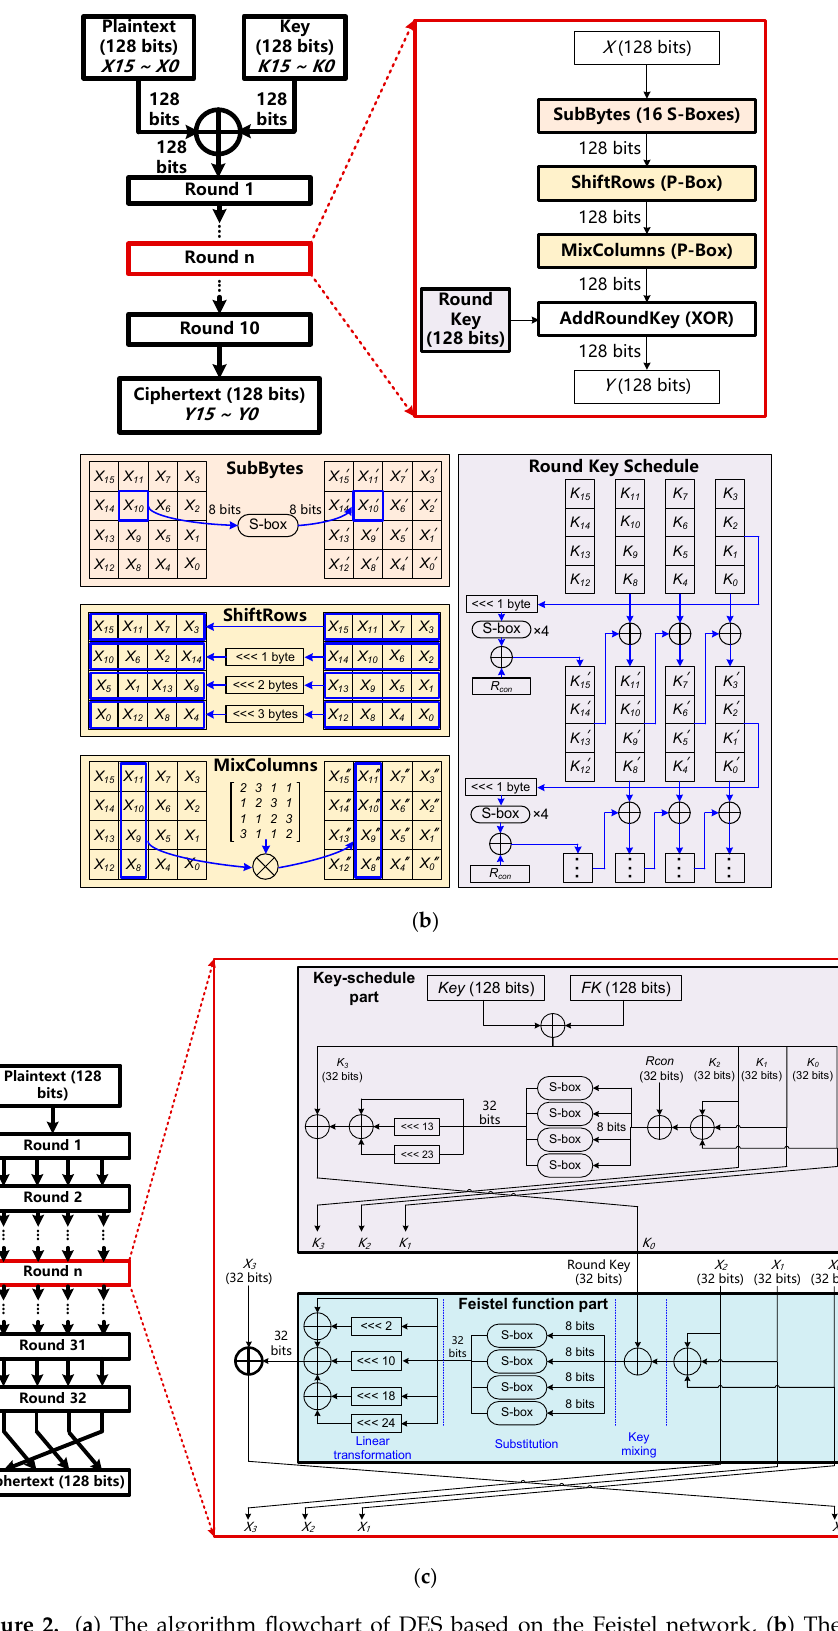
Figure 2. ( a ) The algorithm flowchart of DES based on the Feistel network, ( b ) The algorithm flowchart of AES based on the SP network, and ( c ) The algorithm flowchart of SM4 based on the Feistel